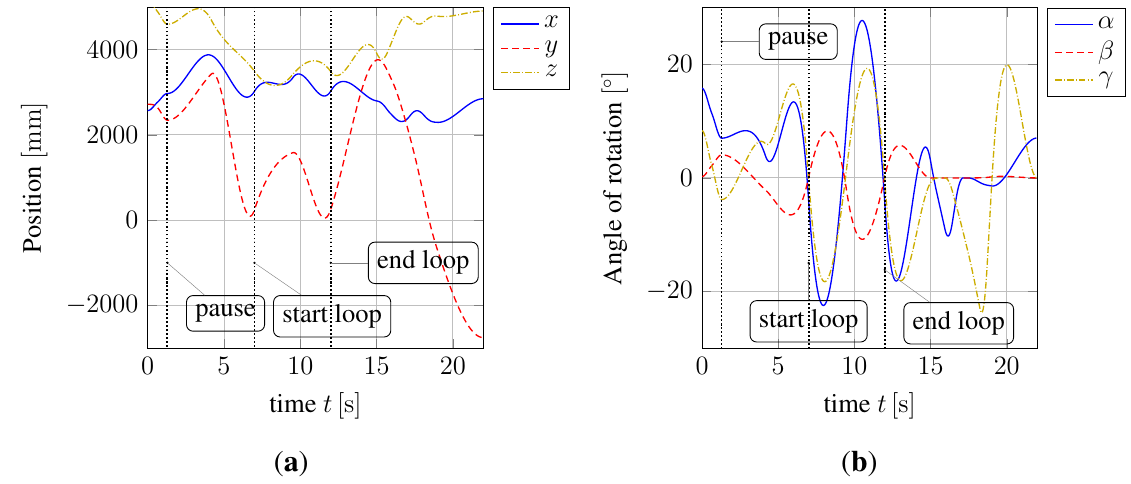
Figure 8. Test trajectory with ( a ) Cartesian coordinates x , y , z and ( b ) Cardan angles α , β and γ of the robot’s platform.